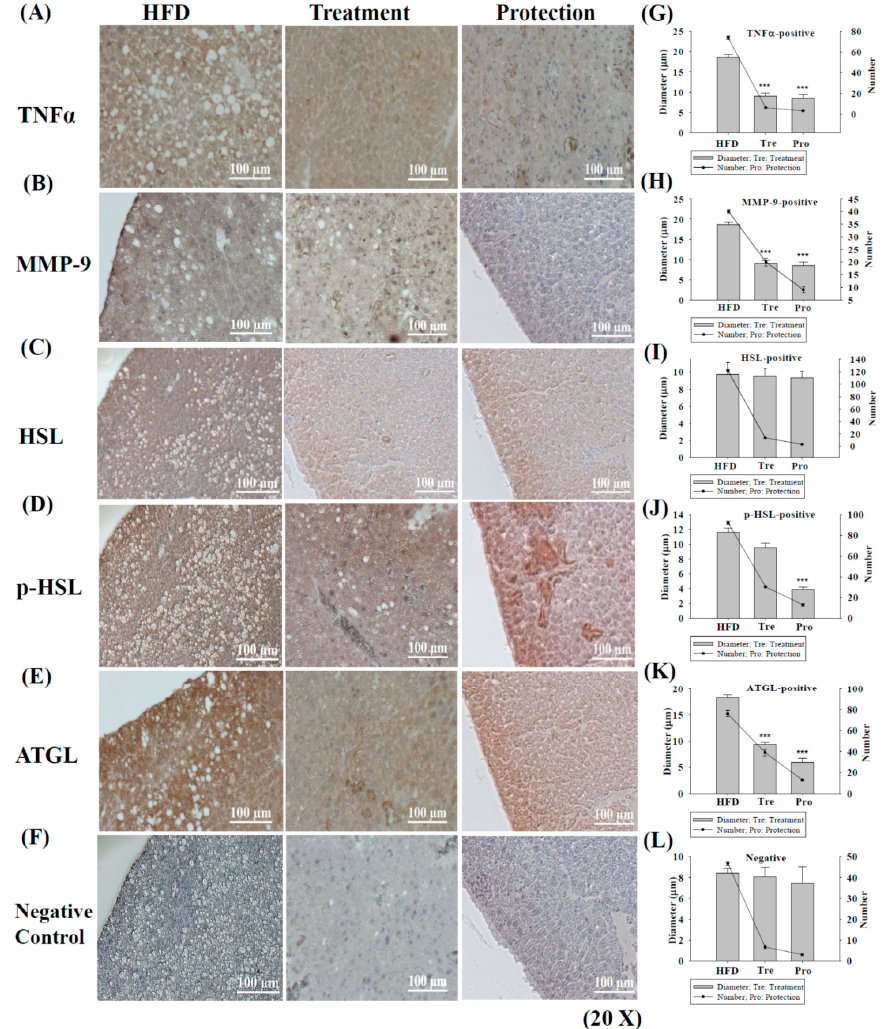
Figure 3. Immunohistochemistry (IHC) staining of tumor necrosis factor α (TNF α )/matrix metallopeptidase 9 (MMP-9), hormone sensitive lipase (HSL)/phosphorylated HSL (p-HSL) and adipose triglyceride lipase (ATGL) in HFD-induced liver steatosis and oil globules protected/treated with KMUP-1 for 14 weeks/6 weeks. HFD-induced fatty liver at 14 weeks implied that oil globules were rich in liver tissues. The expression of HFD-induced TNF α ( A ) and MMP-9 ( B ) in the treatment and protection groups; Treatment and/or protection with KMUP-1 sharply reduced the number and diameter of oil globules ( G , H ); HFD-induced the expression of HSL/p-HSL showed that KMUP-1 could affect the HSL protein (brown, C ); and significantly enhanced the active form of HSL (p-HSL) in the protection group (deep brown, D ) and matched data regarding the number and diameter of oil globules depicted in ( I , J ); ATGL expression is not affected by KMUP-1 in both treatment and protection groups ( E ); but markedly attenuated the number and diameter of oil globules ( K ); ( F , L ) negative control of protein expression, and the number and diameter of oil globules. Data are means ± S.E. of three independent experiments. *** p < 0.001 versus HFD group.